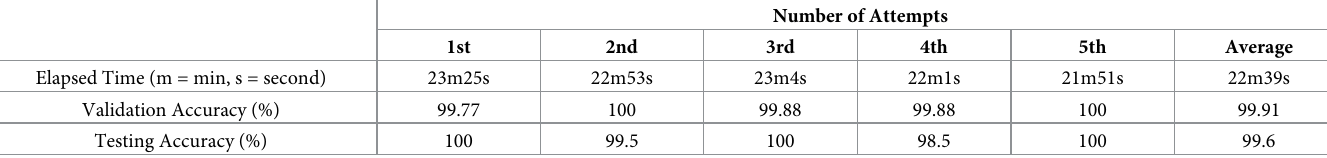
Table 2. Performance of our CNN architecture on image modality and anatomical location classification.